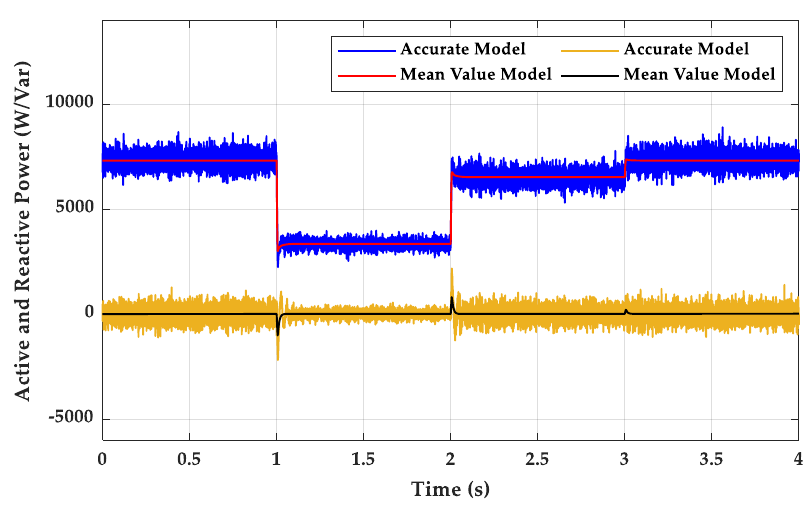
Figure 8. Active and Reactive Power injected to the grid.